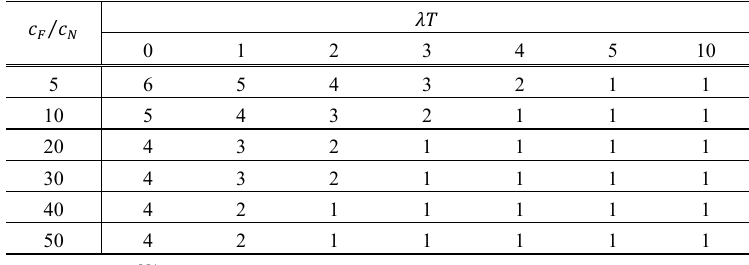
Table 1. Optimal 𝑁 0∗ when 𝜔𝐾 = 10